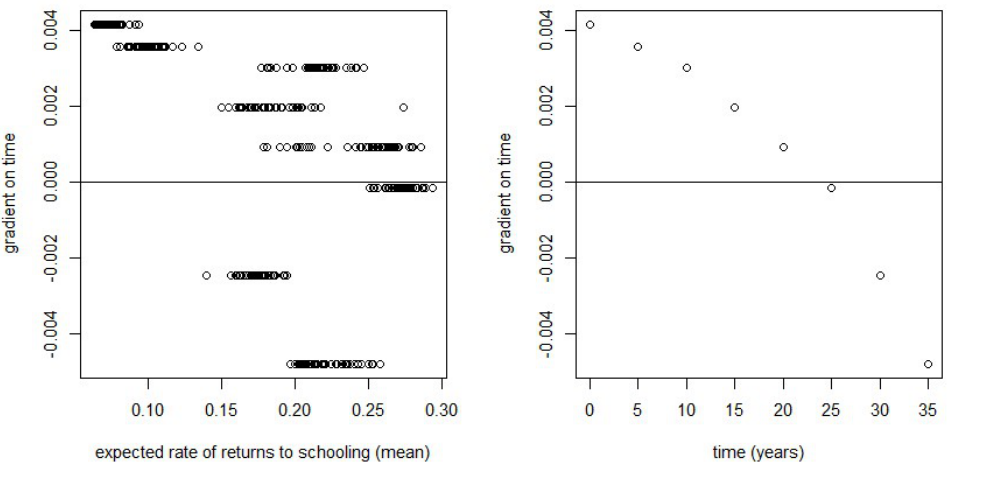
Figure 15. Spline gradients on time trend from Step